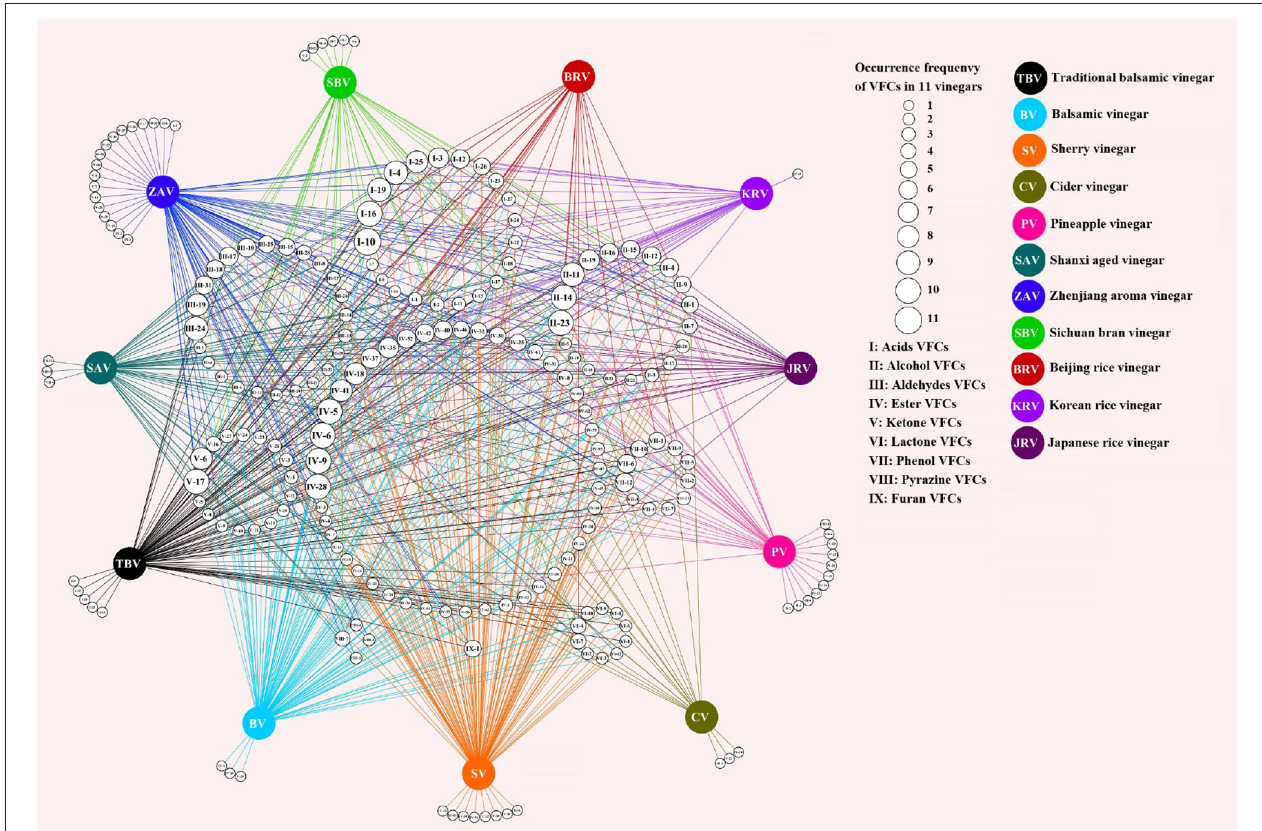
FIGURE 4 | The shared and unique VOCs from different kinds of vinegar. The numbers in the small white circles in the middle represent the kinds of vinegar volatile organic components (VVOCs) ( Annex Table 3 ) shared in different kinds of vinegar, and the sizes of the circles indicate the occurrence frequencies of VVOCs, and the larger the circle, the higher the frequencies of VVOCs in kinds of vinegar; the colorful circles represent the different kinds of vinegar; the numbers in the circles on the outside of the different kinds of vinegar express the unique VVOCs of the corresponding kinds of vinegar. The figure was drawn via Cytoscape v.3.7.2 (Shannon et al.,